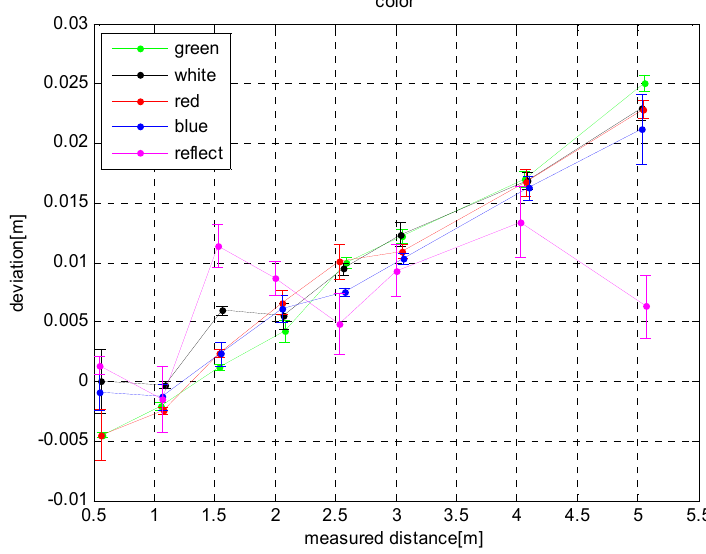
Figure 5. Influence of color on depth errors.